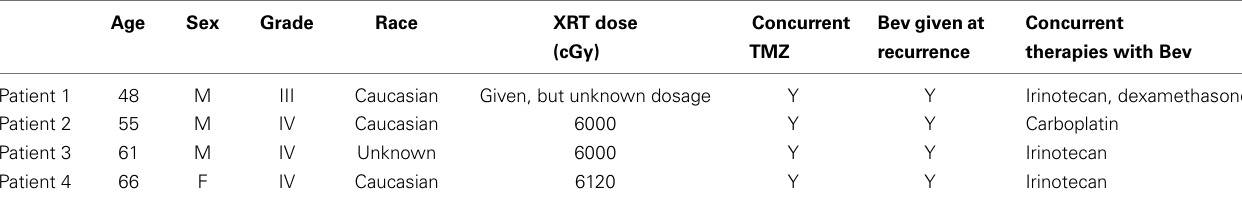
Table 1 | Demographic and treatment information corresponding to patients in Figure